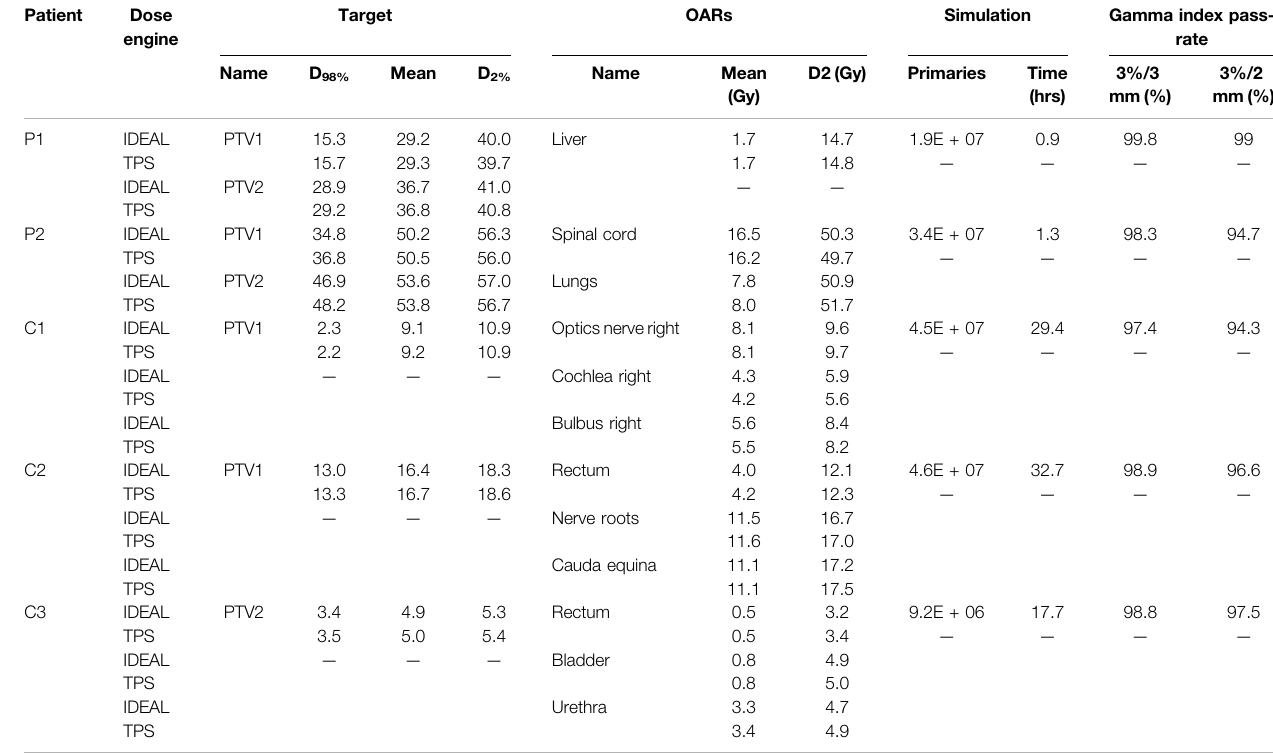
TABLE 5 | Comparison of IDEAL simulations with TPS. Key clinical quantities for the target volumes (D 98% , Mean dose, D 2% ) and organs at risks (Mean dose, D 2% ) are considered, as well as simulation times and gamma index pass-rates. Patient Dose